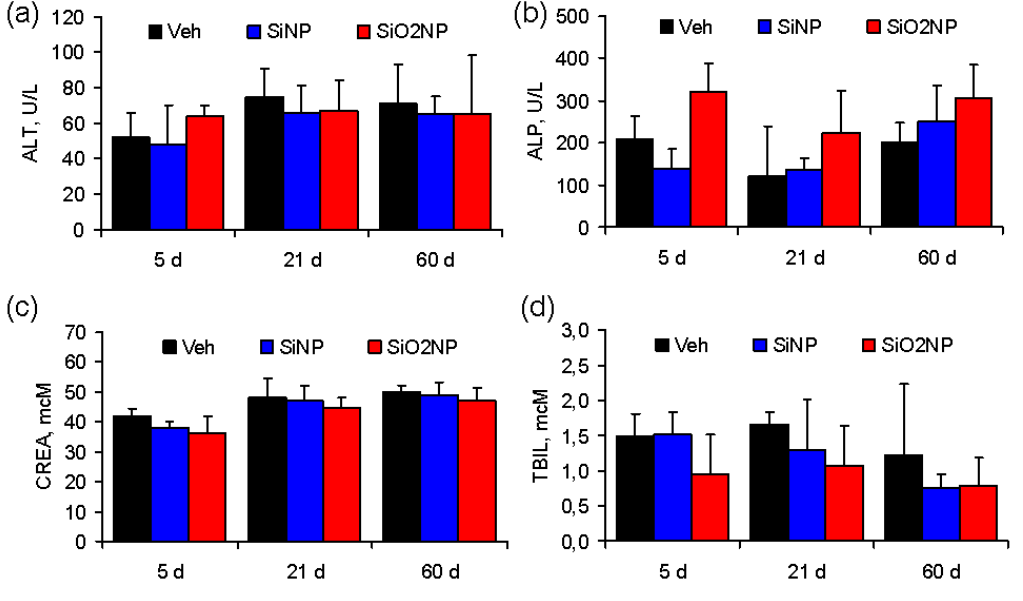
Figure 5. Biochemical serum markers in Sprague-Dawley rats treated with vehicle, SiNPs, or SiO NPs at a dose of 7 mg/kg. The results show mean values and standard deviations of 2 ( a ) alanine transaminase (ALT); ( b ) alkaline phosphatase (ALP); ( c ) creatinine (CREA); and ( d ) total bilirubin